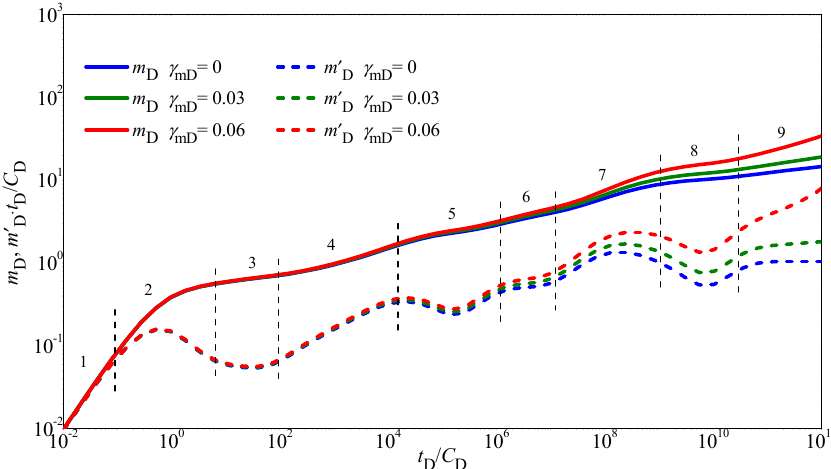
Figure 4. Influence of the permeability modulus on the pressure dynamic curve of the dual medium composite reservoir.